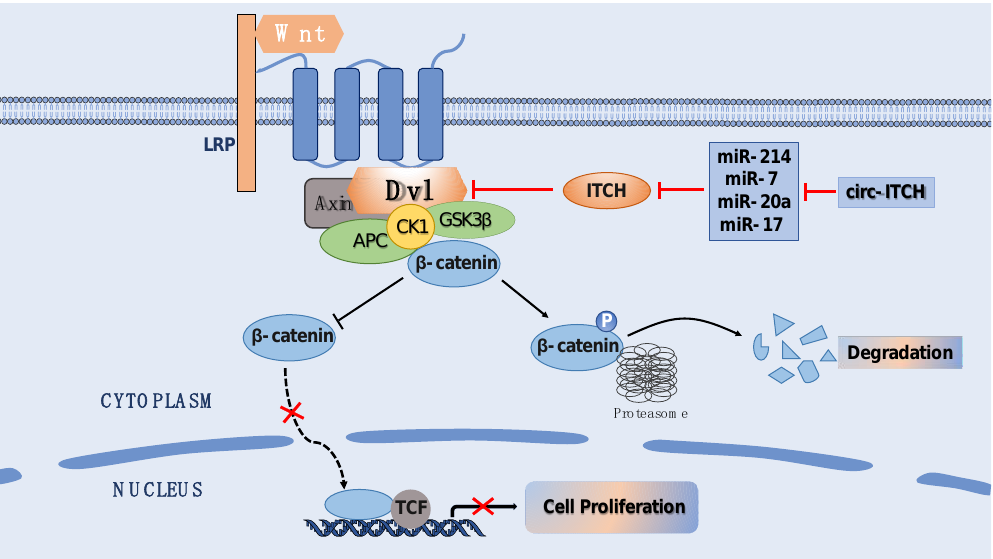
Figure 3. Circ-ITCH-mediated inhibition of Wnt/ β -catenin signaling. In the pathway, Dvl protein could remain β -catenin stable by inhibiting APC, Axin and GSK3 β to form destruction complexes. The stable accumulation of β -Catenin in cytoplasm enters the nucleus and binds to the TCF transcription factor to initiate transcription of downstream target genes. Instead, the form of destruction complex mediates β -Catenin phosphorylation and, eventually, phosphorylated β -Catenin is degraded by the proteasome. The circ-ITCH acts on miR-214, miR-7, miR-20a and miR-17 through ceRNA mechanism to regulate target parental gene ITCH. The ITCH-mediated degradation of Dvl leads to β -Catenin degradation and inhibition Wnt/β -catenin signaling.